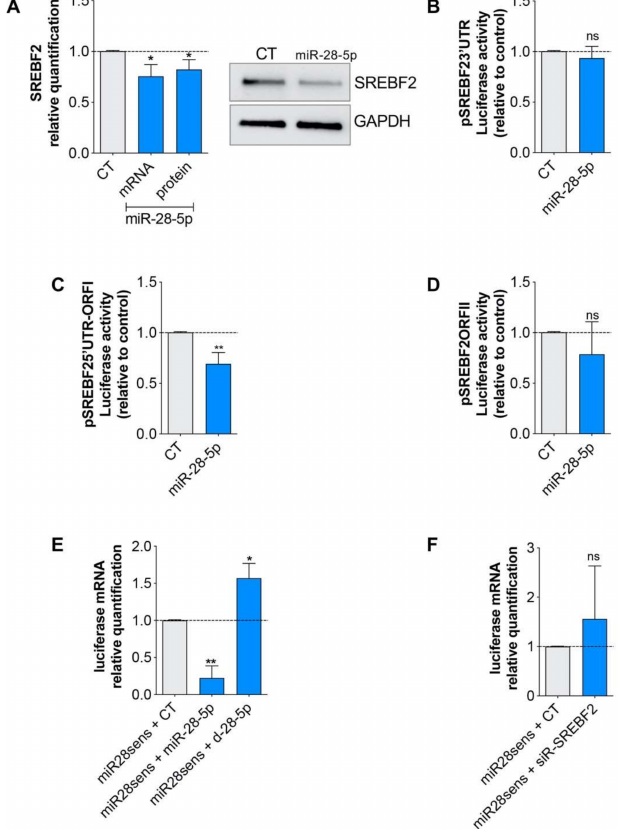
Figure 5. Analysis of miR-28-5p / SREBF2 interaction in PCa cells. ( A ) Quantification of SREBF2 mRNA and protein level in miR-28-5p versus CT transfected DU-145 cells. Relative luciferase activity after the cotransfection of pSREBF2 3 (cid:48) UTR ( B ), pSREBF2 5’UTR-ORFI ( C ), pSREBF2 ORFII ( D ) and either CT or miR-28-5p. ( E ) Relative luciferase mRNA level, analyzed with qRT-PCR, in DU-145 cotransfected with miR-28-5p sensor and miR-28-5p mimic or inhibitor versus miR-28-5p sensor / CT cotransfected cells. ( F ) Relative luciferase mRNA level, analyzed by qRT-PCR, in DU-145 cotransfected with miR-28-5p sensor / siR-SREBF2 versus miR-28-5p sensor / CT cotransfected cells. * p < 0.05, ** p < 0.01, *** p < 0.001, unpaired t -test. ns, not